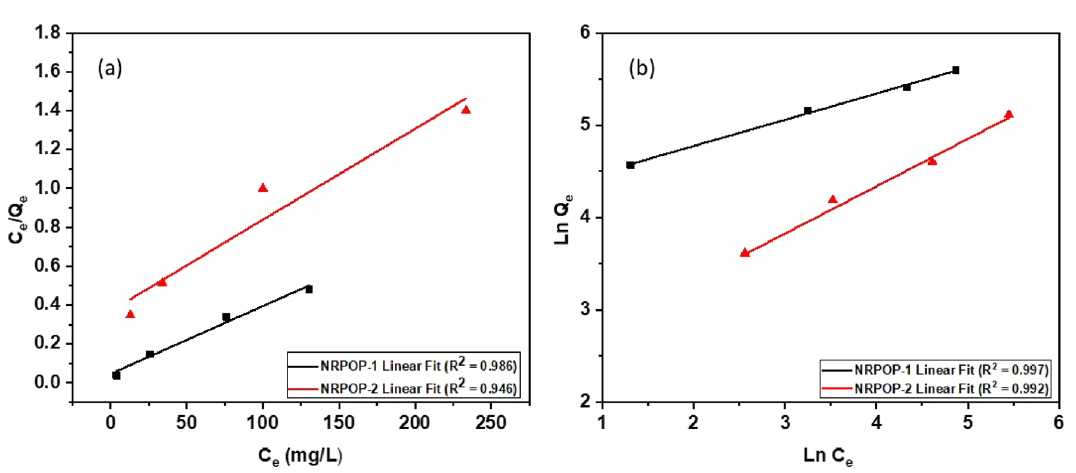
Figure 6. Iodine adsorption by NRPOPs isotherms fitted to Langmuir model ( a ) and Freundlich model ( b ). R 2 is the correlation coefficient of the linear